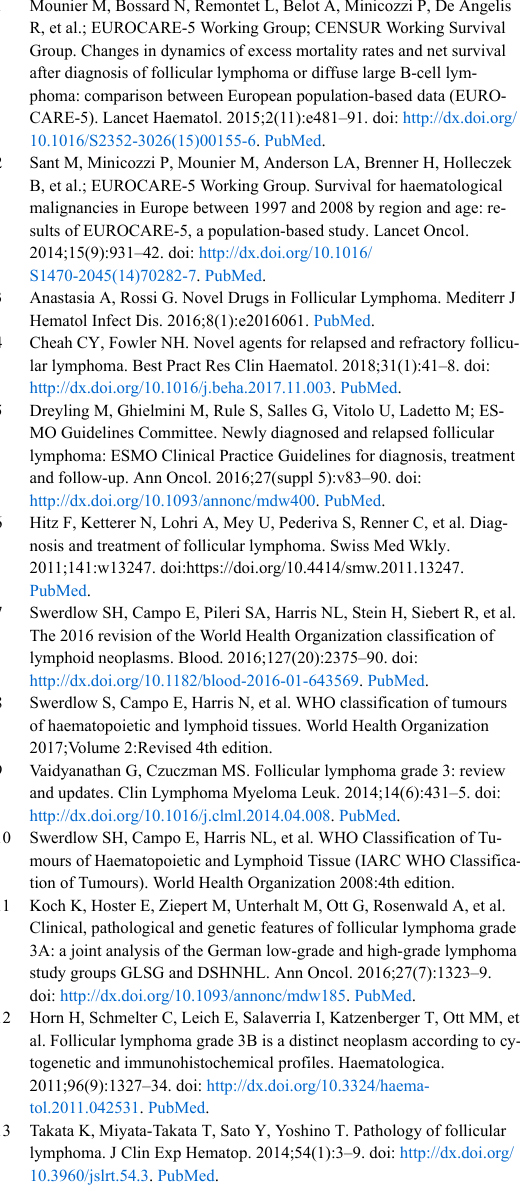
Blood counts and routine chemistry tests Thyroid function Radiological or ultrasound